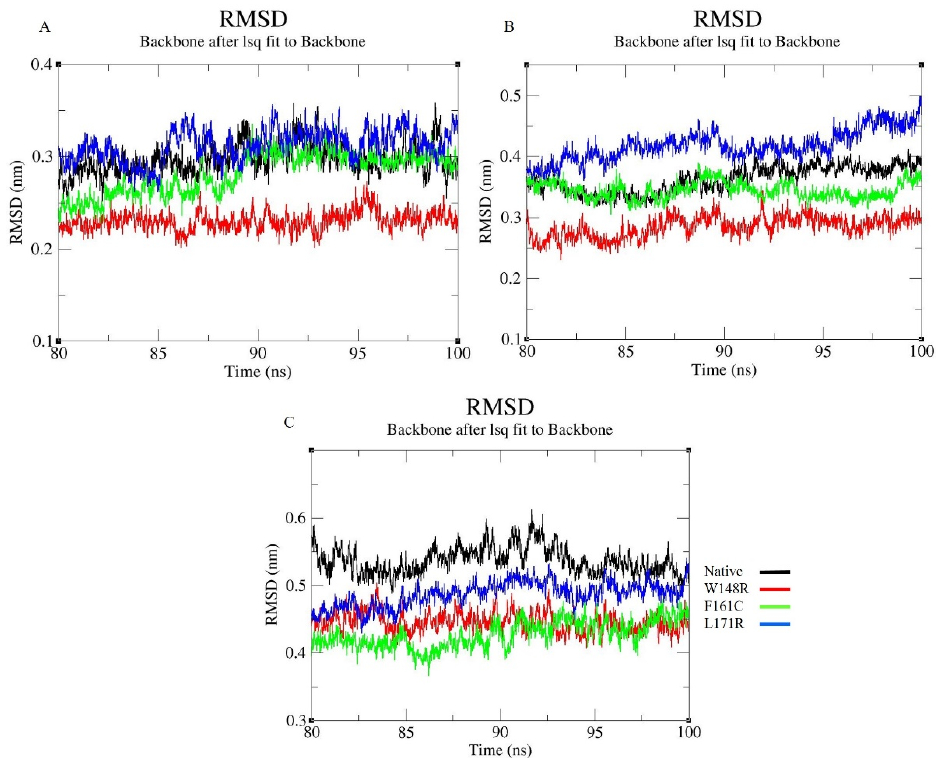
Figure 2. The block-based RMSD graph representing MDS for 80ns-100ns of native and mutants ( A ) CH1 domain (residues from 16–122); ( B ) CH2 domain (residues from 139–242); and ( C ) whole proteins, with X-axis representing time (ns) and Y-axis representing RMSD (nm). Color scheme: Native (Black), W148R (Red), F161C (Green), L171R (Blue).